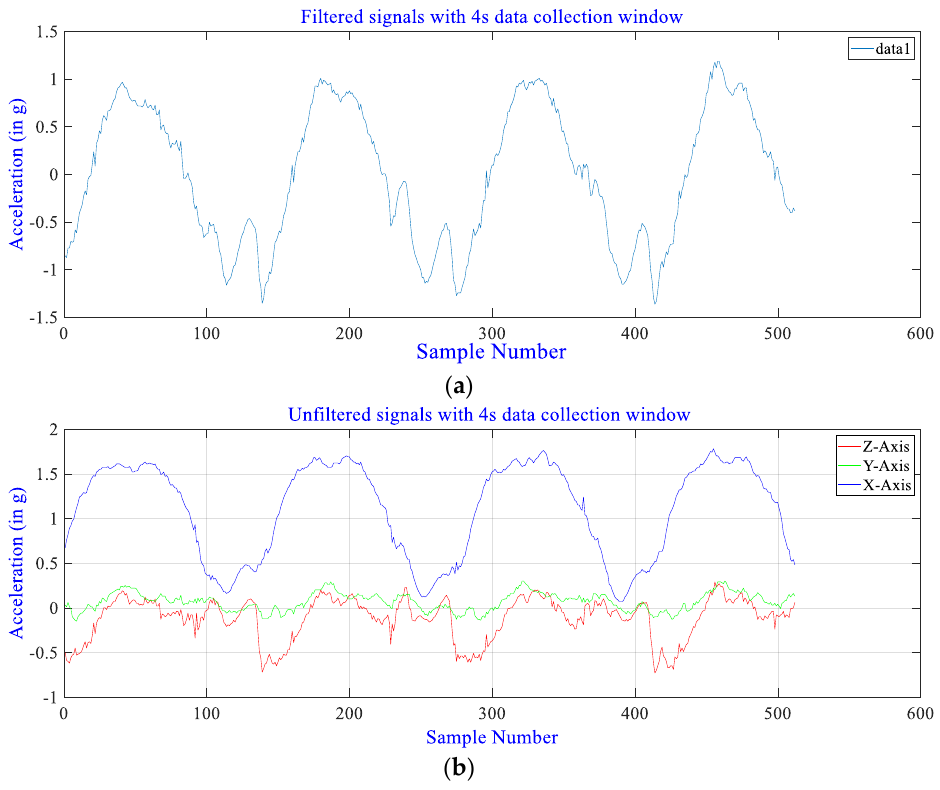
Figure 3. ( a ) The raw signals after applying filter techniques. ( b) The raw signals before filtering.